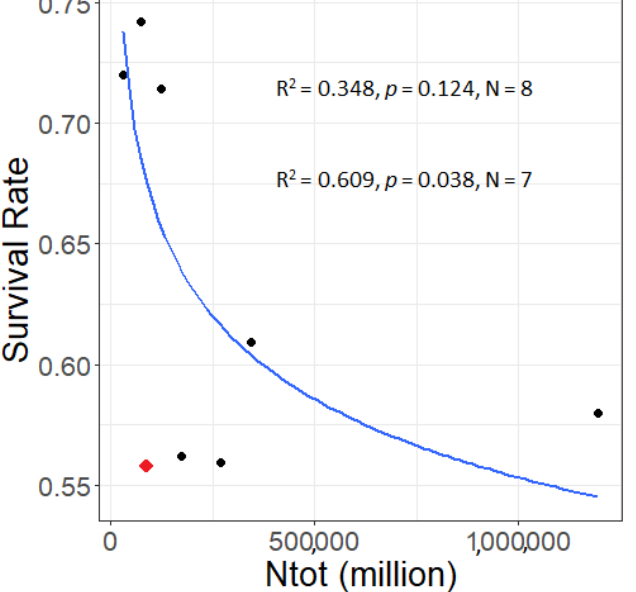
Figure 6. Relationship between larval survival (Survival) and total larval abundance (Ntot in millions). The power model best describes the relationship between these variables. The panel shows R 2 and the p . The relationship is statistically significant when the year 1998 (red point) is excluded.